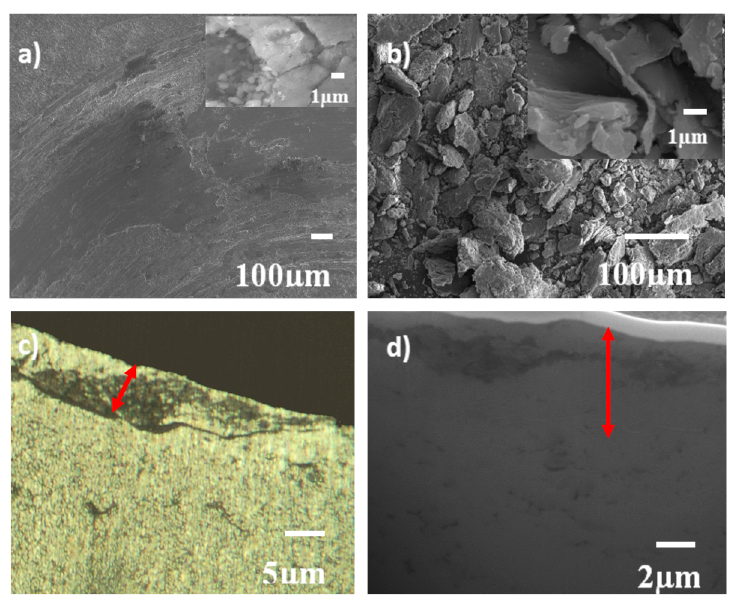
Figure 8. SEM images of the Al-2 vol % GNP (RT) ( a ) wear track and ( b ) wear debris, ( c ) Optical micrograph of the sub-surface of the wear track, ( d ) FIB image of the sub-surface of the wear track.